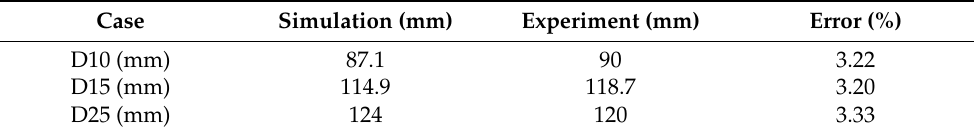
Figure 19. Top views of molded parts at 0.4 s, 0.6 s, and 1.0 s. Table 5. Flow front comparison.